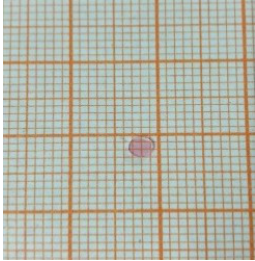
Figure 2. The example of polished disk for the spectral measurements.